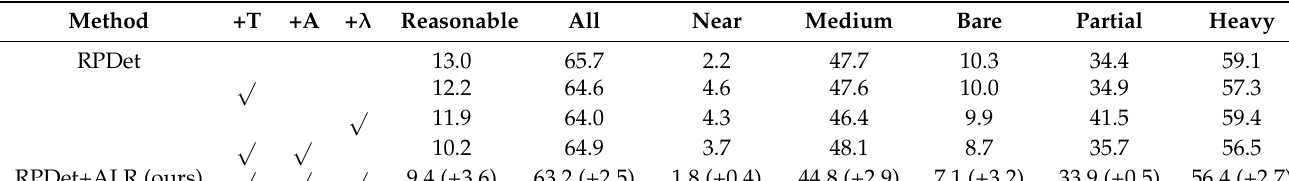
Table 1. Results of RPDet-based models on the Caltech-USA testing set (MR − 2 /%).